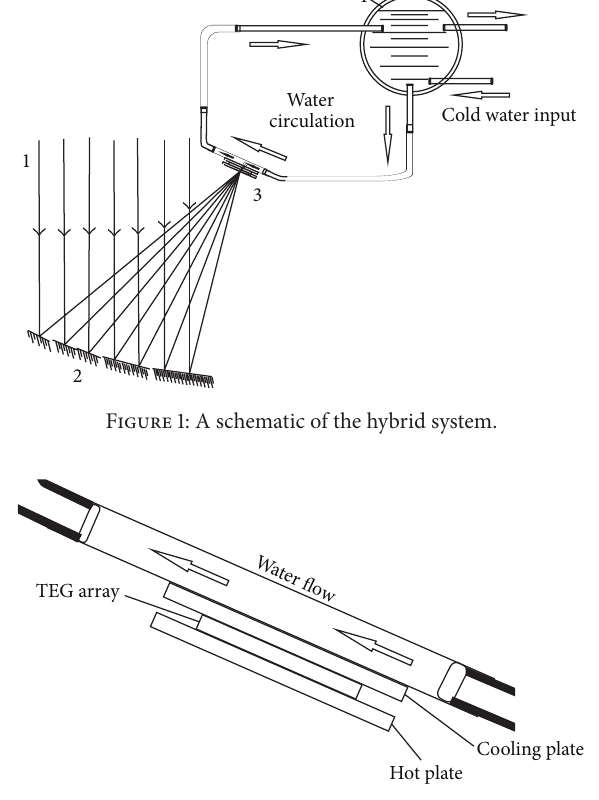
Figure 2: Thermoelectric generating (TEG)